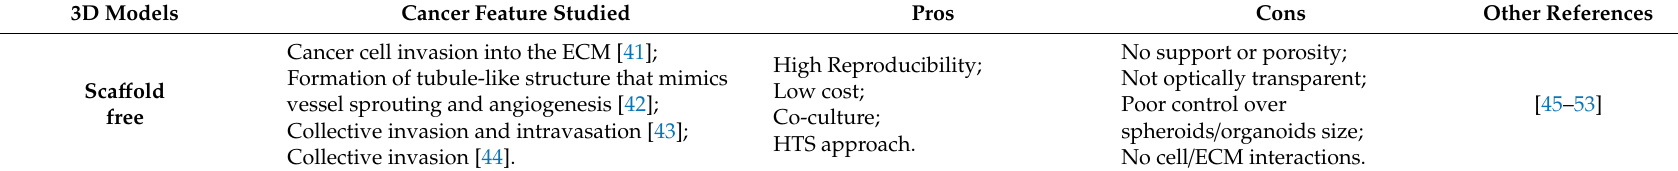
Table 1. 3D Model Technologies Advantages and Limits. BC: breast cancer, BM: bone microenvironment, ECM: extracellular matrix, HA: hydroxyapatite, IL: interleukin, OT: osteoblastic tissue, PC: prostate cancer, TME: tumor